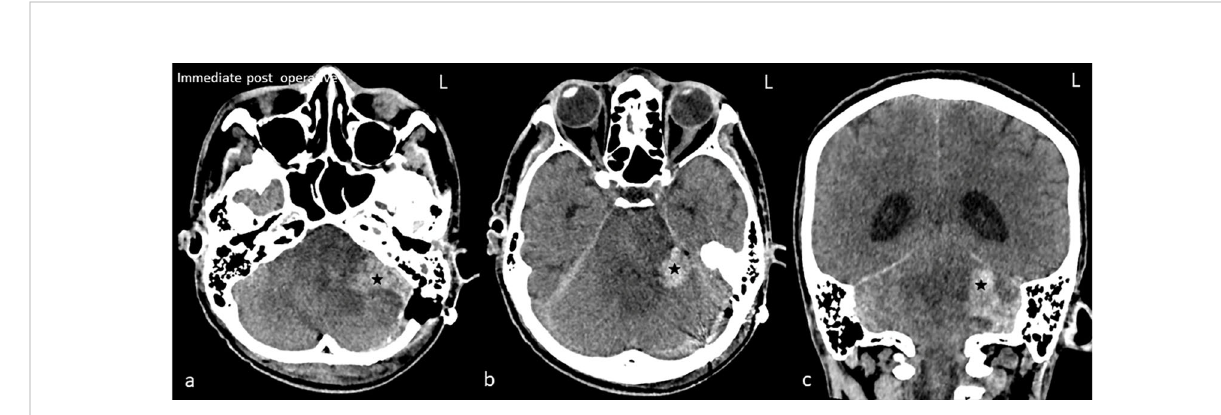
FIGURE 4 Immediate post-op plain computed tomography of the brain in axial (A, B) and coronal (C) . Hyperdense hematoma (star) at the left cerebellopontine angle is seen. The fourth ventricle is obliterated with resultant hydrocephalus.